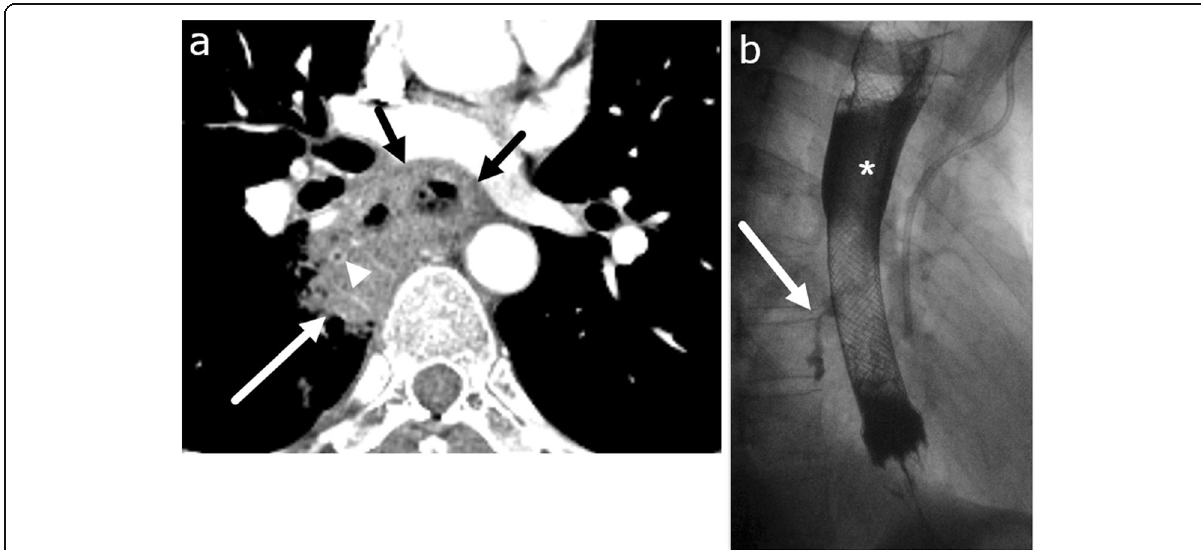
Fig. 4 Malignancy-induced esophageal perforation and esophago-bronchial fistula. Forty-nine-year-old male with recently diagnosed esophageal cancer presenting with chest pain. a Axial CT image shows circumscribed mass of the lower esophagus consistent with esophageal cancer (short black arrow). The esophagus is perforated into the right lower lobe containing debris and gas (white long arrow). The medial basal segment bronchus is encased by the debris (arrowhead). An esophageal stent was urgently placed. b Esophagography obtained 2 weeks after placing the esophageal stent shows an esophago-bronchial fistula (arrow). Appropriate position of esophageal stent (asterisk) is